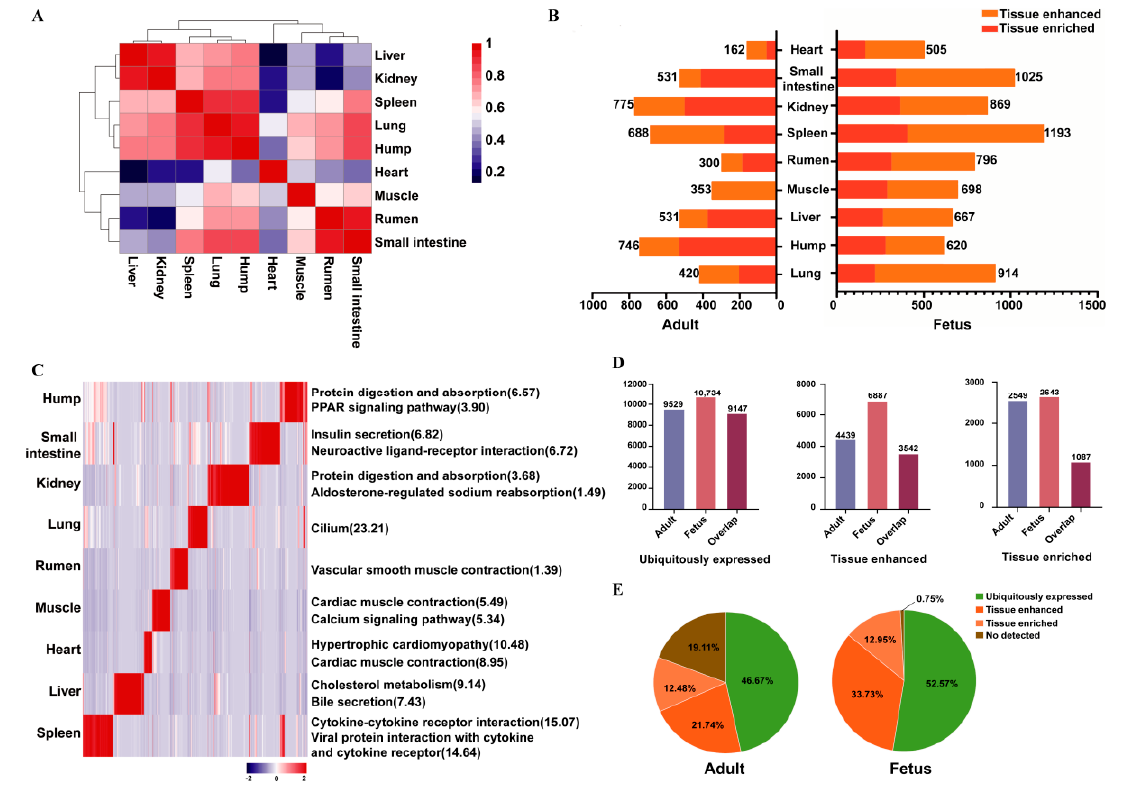
Figure 1. Classification of protein-coding genes in Bactrian camels. ( A ) Global correlation analysis of transcriptomes across adult tissues based on 20,417 protein-coding genes. Transcript levels were expressed as fragments per kilobase of exon per million fragments mapped. ( B ) Number of tissue-enhanced genes and tissue-enriched genes in nine tissues of adult camels. ( C ) Expression profiles of tissue-elevated genes with the corresponding GO terms and KEGG pathways. ( D ) Number of ubiquitously expressed genes and tissue-elevated genes in adults and fetuses. ( E ) Gene classification based on the level of expression.